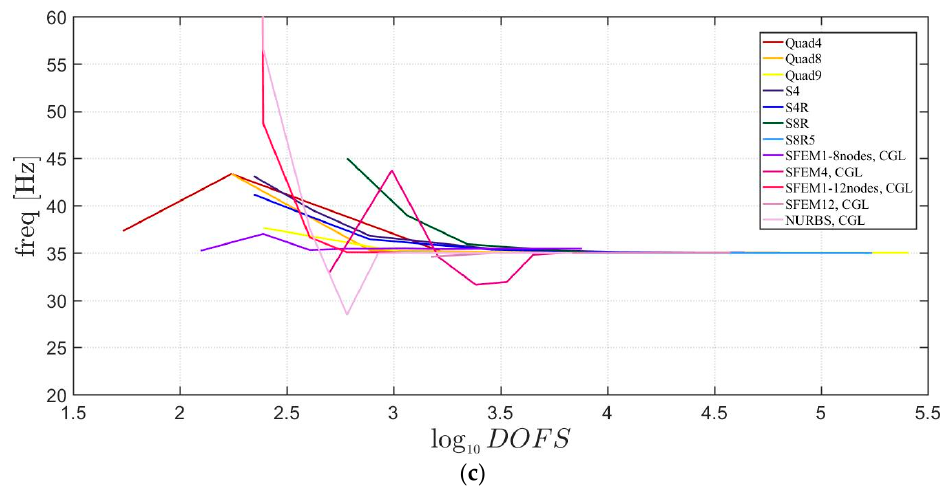
Figure 8. First three natural frequencies of an isotropic elliptic plate with b / a = 2: ( a ) First frequency; ( b ) Second frequency; ( c ) Third frequency.